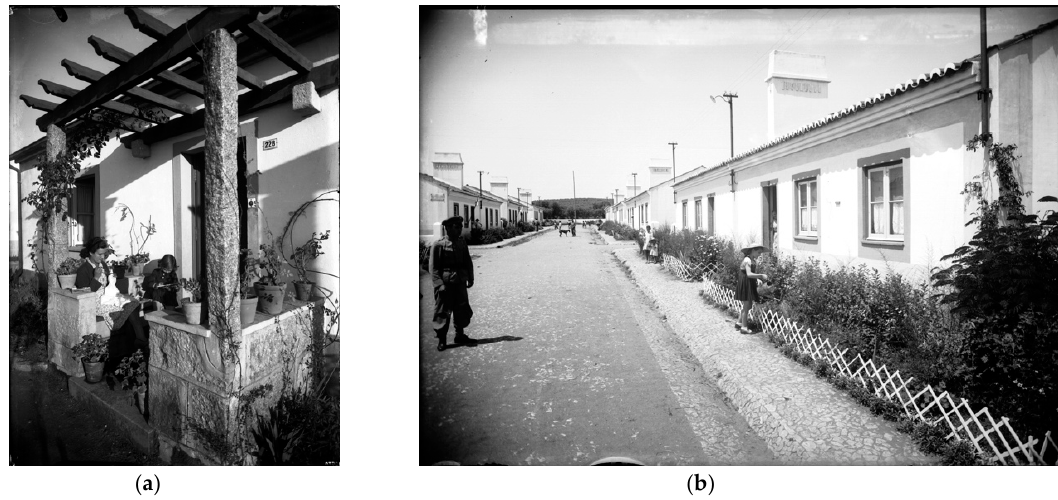
Figure 5. Affordable Houses Estates in Porto, Portugal: ( a ) Entrance porch; ( b ) Street view.